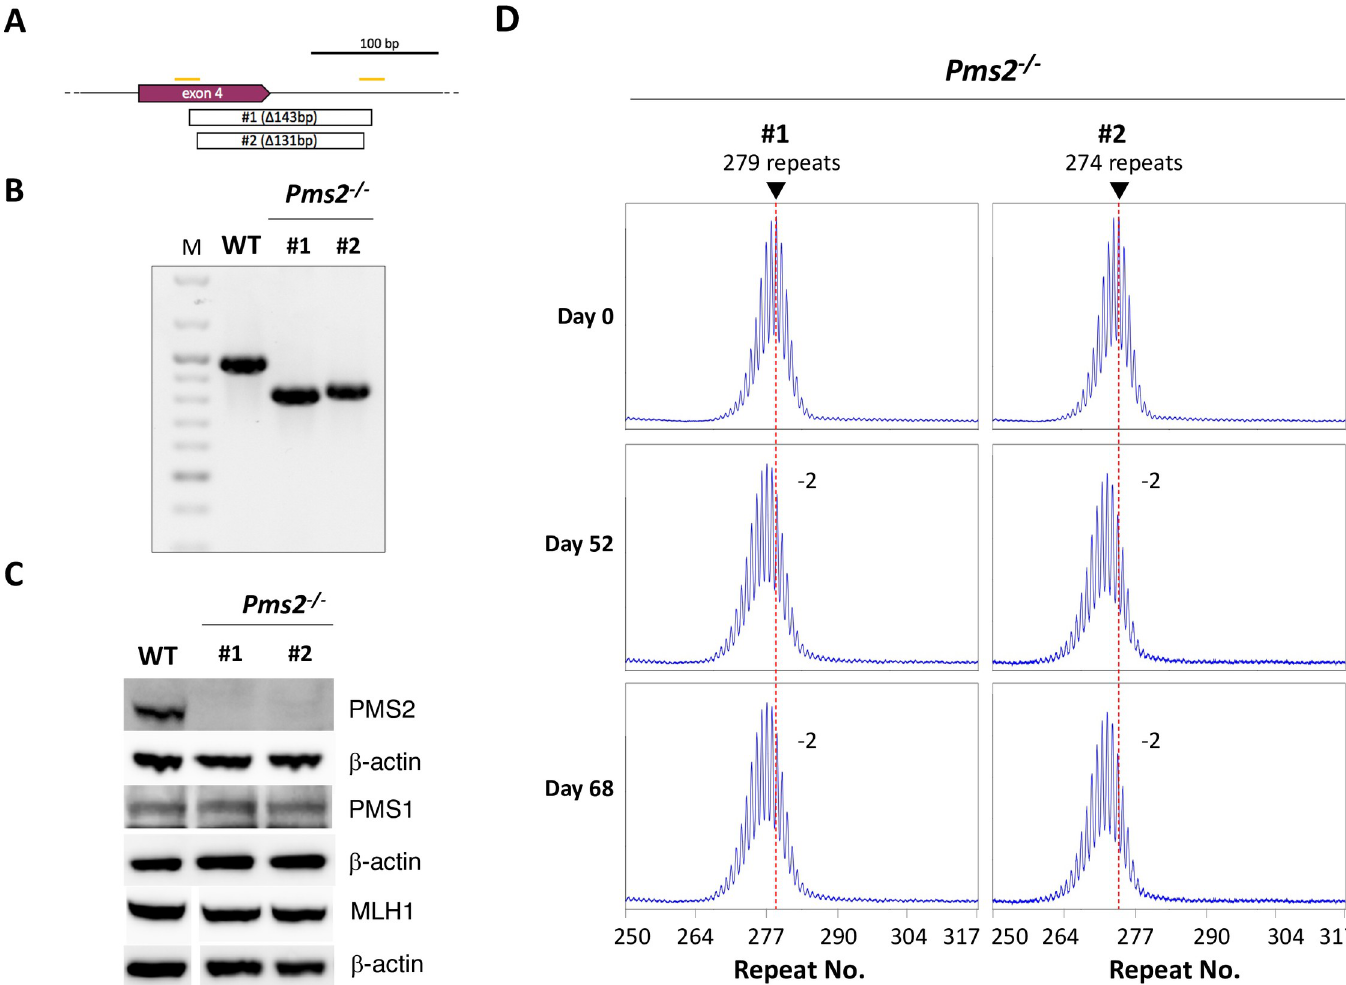
Fig 4. Generation and analysis of Pms2 -/- cell lines. A) Diagram of mutations generated in exon 4 of Pms2 . Orange bars: CRISPR gRNA target. Open boxes: extent of CRISPR-induced deletion in the indicated lines. B) PCR analysis of DNA from Pms2 +/+ cells and the two Pms2 -/- CRISPant cell lines shown in panel A. M: 100 bp molecular weight ladder. C) Western blot demonstrating that the edited cells lack PMS2 and that the loss of PMS2 does not affect the levels of MLH1 or PMS1. Note that the lanes in the MLH1 western blot shown here are from the same blot shown in Figs 2C and 5C. D) Repeat PCR profiles of the two Pms2 -/- lines after 0, 52 and 68 days in culture. The red dotted line on each profile indicates the major allele present in the cell population at day 0. The numbers indicate the change in the repeat number relative to day 0.